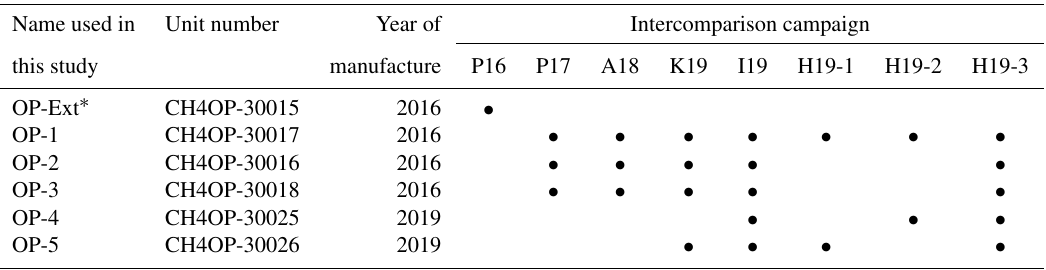
Table 1. GasFinder3-OP devices and their deployment in the different intercomparison campaigns. Details on the intercomparison campaigns are given in Table 2.